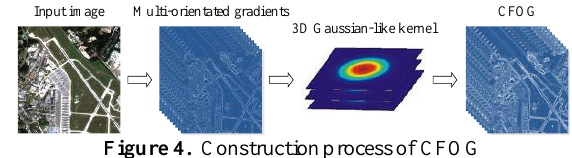
Figure 4. Construction process of